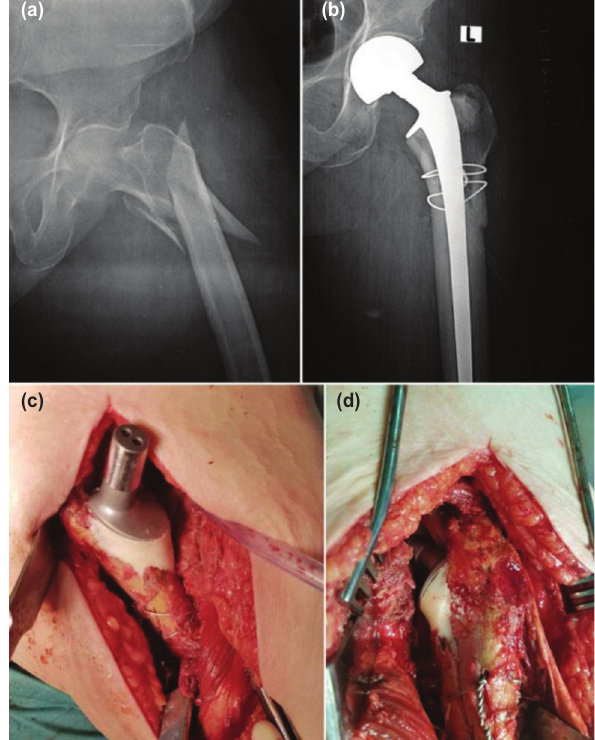
Unstable reverse oblique fracture with (a) Pre- and (b) Post-operative radiographs and intraoperative images showing the Fig. 1: reconstruction of the greater trochanter and the cemented stem (c) Before and (d) After reduction.